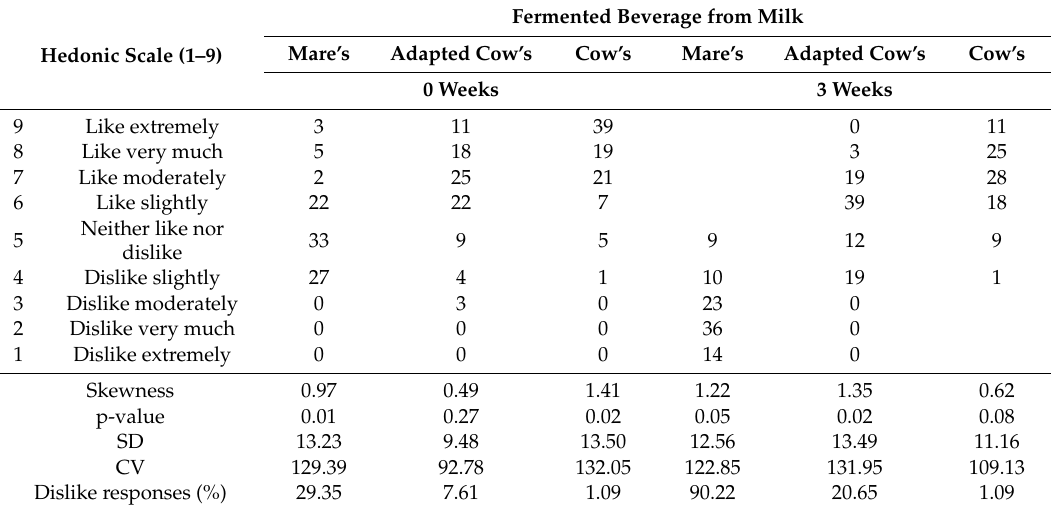
Table 5. Sensory acceptability of color and appearance of fermented beverages from mare’s milk, cow’s milk adapted to mare’s milk composition, and cow’s